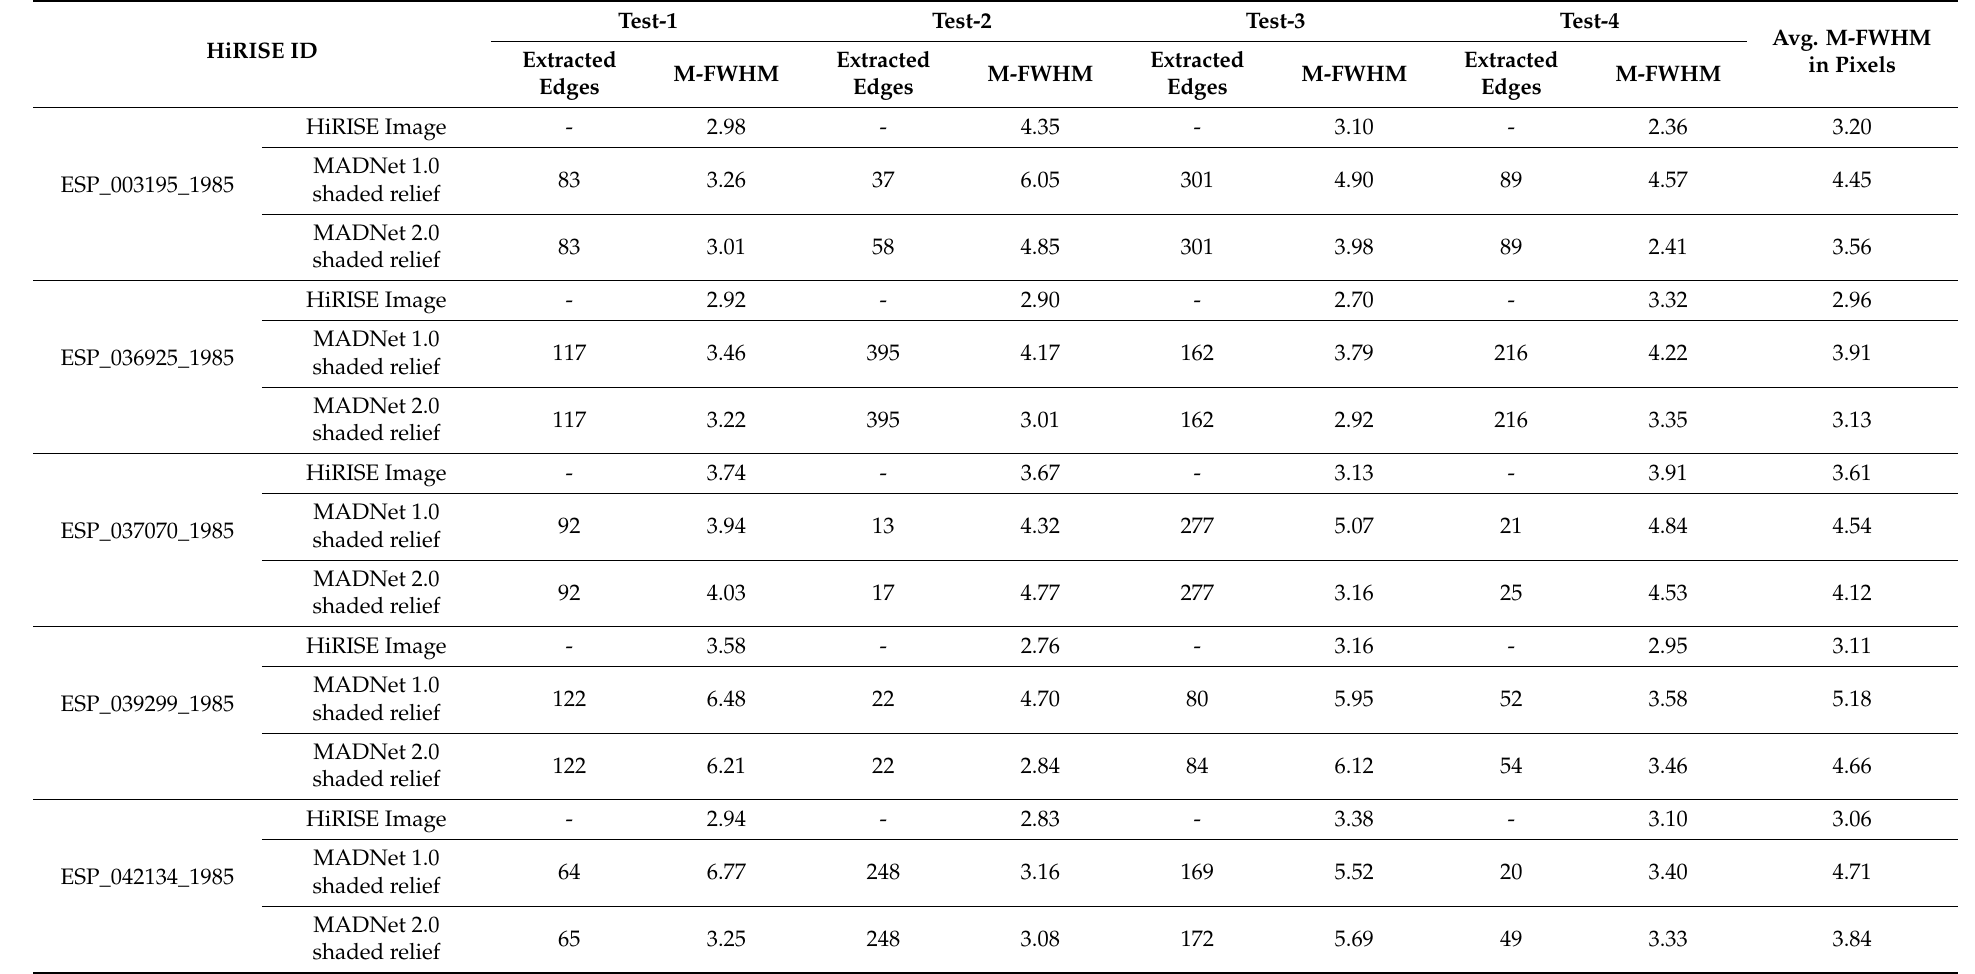
Table 2. Summary of the ELF measurements of the HiRISE image, hill-shaded relief images of the MADNet 2.0 and MADNet 1.0 DTMs, for the four pre-selected areas for each of the five test HiRISE